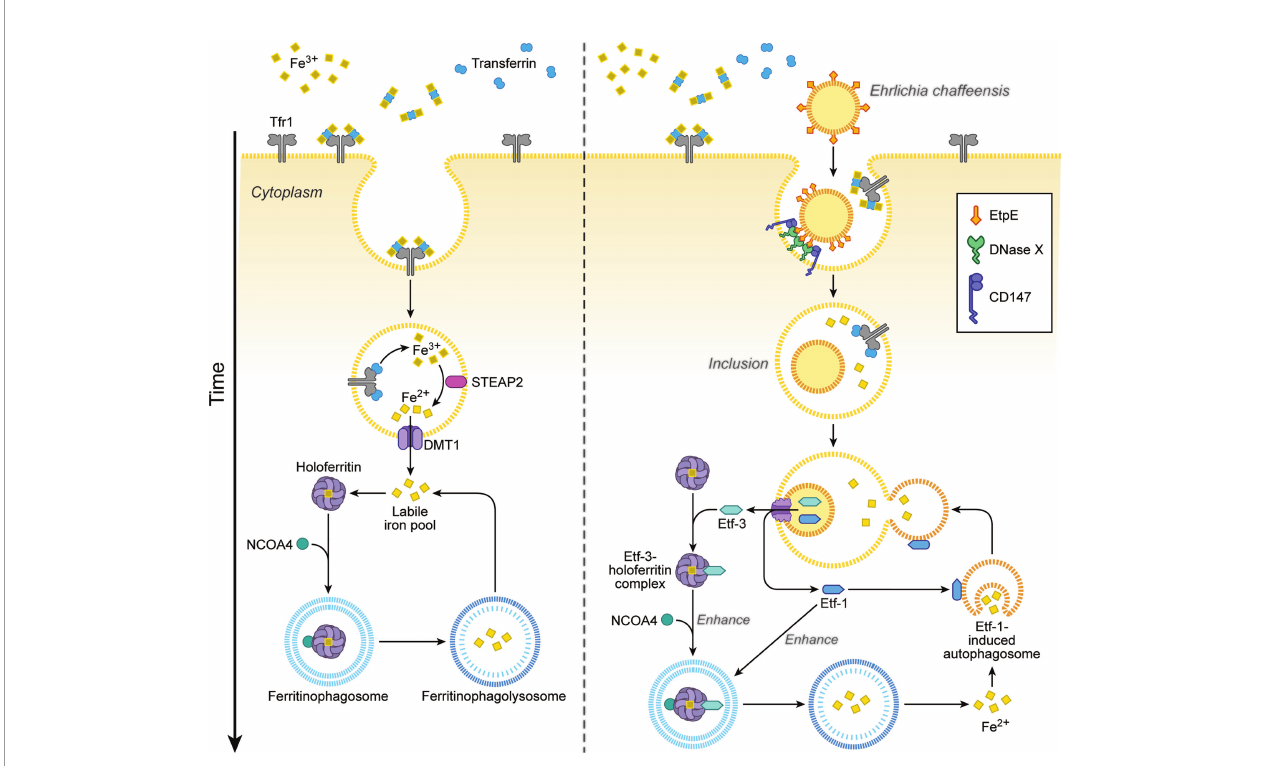
FIGURE 4 | Ehrlichia chaffeensis Etf-3 binds ferritin light chain to induce ferritinophagy to increase the labile-iron pool for acquisition of iron by E. chaffeensis . Iron homeostasis is tightly regulated in host cells to maintain the labile cellular iron pool (left). Etf-3 directly binds ferritin via ferritin light chain and induces ferritinophagy to increase the labile cellular iron pool, thereby providing Fe 2+ for E. chaffeensis proliferation. Etf-1 – induced autophagy synergizes with Etf-3 to deliver extra Fe 2+ to Ehrlichia inclusions (right). Tf: transferrin, which binds Fe 3+ and transports it into cells. TfR: transferrin receptor, which binds and delivers iron-saturated transferrin via endocytosis. STEAP2: Six-transmembrane epithelial antigen of prostate-2, a metalloreductase that reduces Fe 3+ to Fe 2+ . DMT1: Divalent metal transporter 1 that transports Fe 2+ from endosomes to the cytoplasm. NCOA4: Nuclear receptor coactivator 4, a cargo receptor that mediates ferritinophagy. The drawing is from